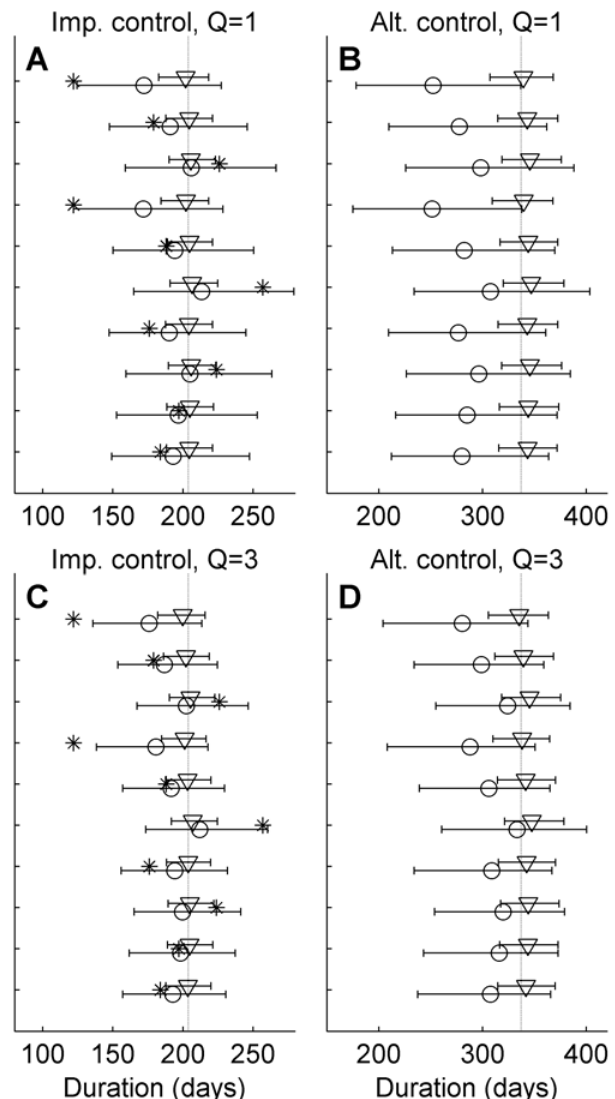
Fig 8. Analysis of synthetic data. Triangles and circles indicate the median posterior estimates of mean outbreak duration after analysis with the small and large discrepancy ensemble, respectively, under the implemented (Panels A and C) and alternative (Panels B and D) control action. Results are shown for ten realizations of synthetic data simulated with k1 = k2 = 1. The error bars indicate the 95% credibility interval, the dashed lines the true values and the star the individual realization (expected to frequently lie outside the predicted mean). Panels A and B show the results of single quantity analysis (only outbreak duration) and Panels C and D the corresponding results of analyses where number of infected farms and control culls are